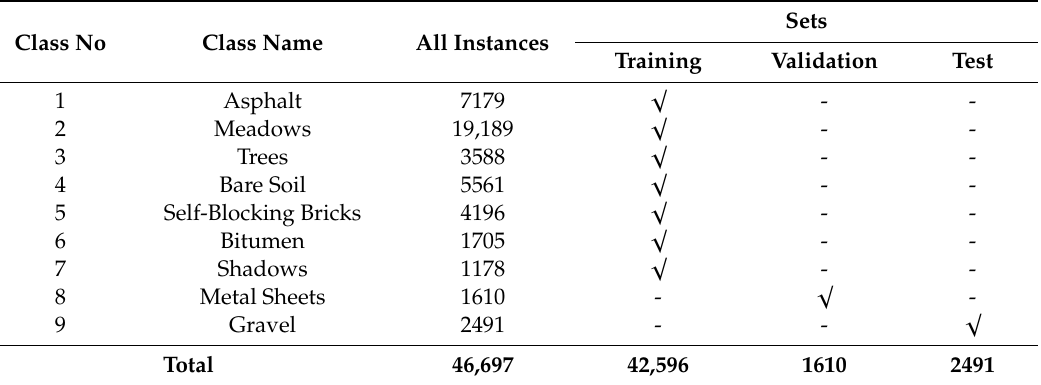
Table 2. Pavia University